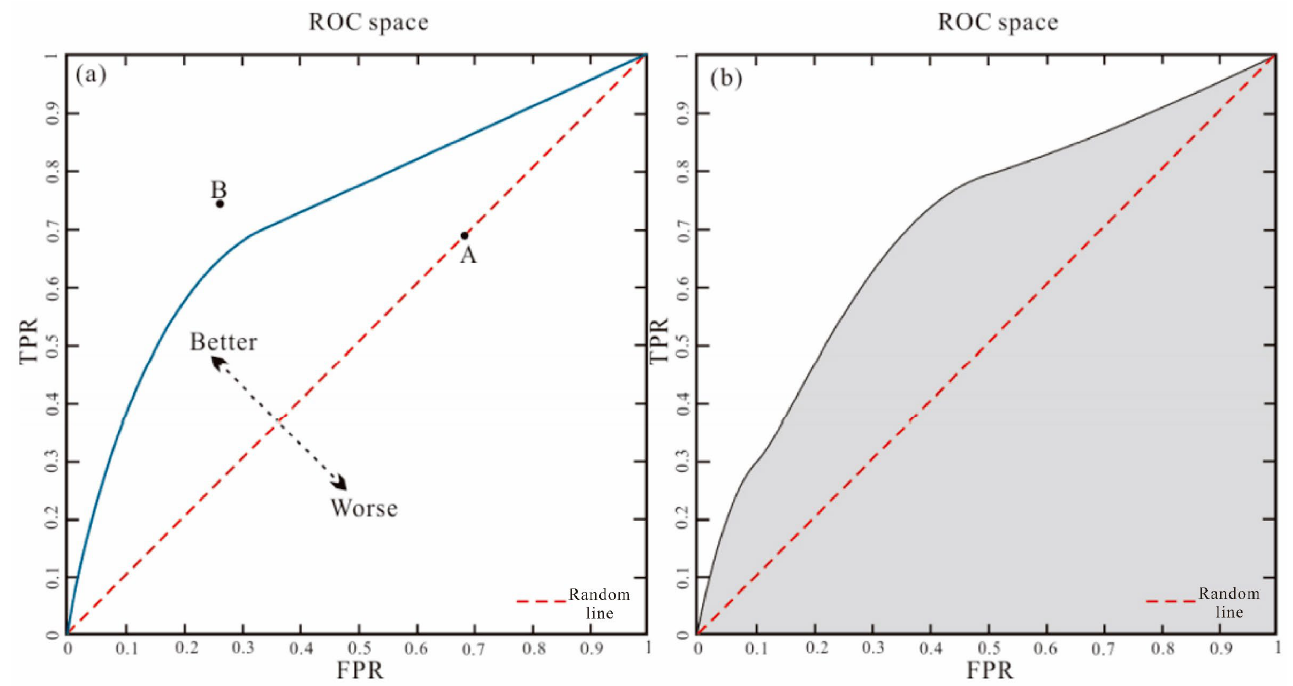
Figure 11. ROC curve diagram ( a ) ROC chart ( b ) AUC chart.